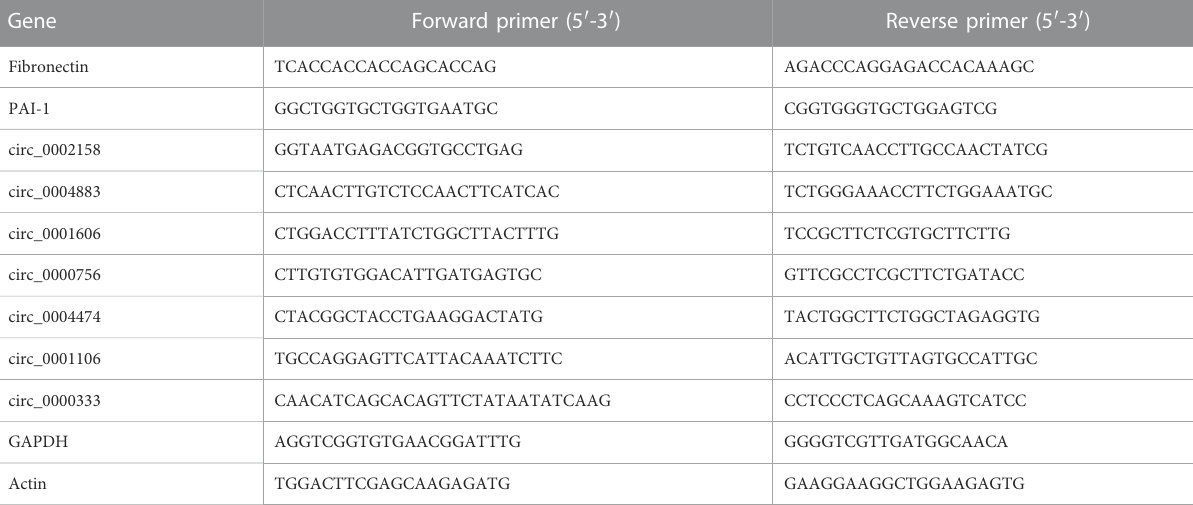
TABLE 1 The genes and primers used for qRT-PCR experiments. Gene Forward primer (5 ′ -3 ′ ) Reverse primer (5 ′ -3 ′